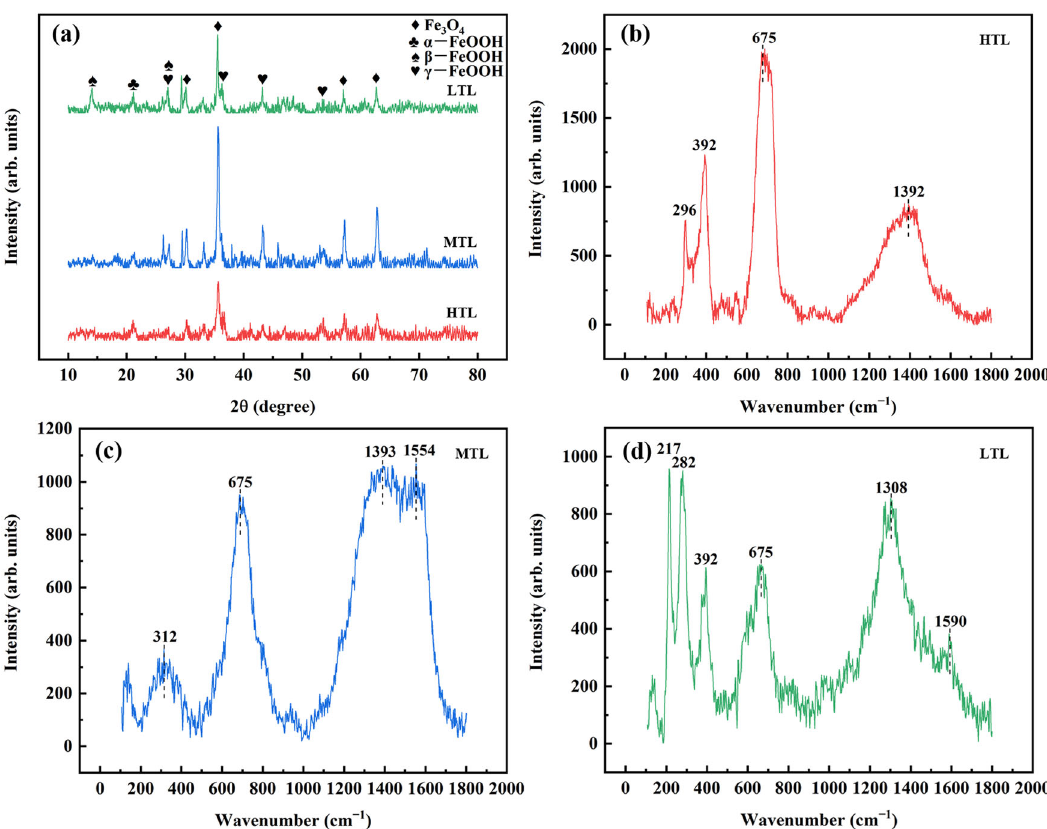
Fig. 4 Component analysis of the corrosion products formed on the surface of the AISI 4135 steel coupons after exposure to the tidal zone for 3 months. a XRD patterns and b – d Raman